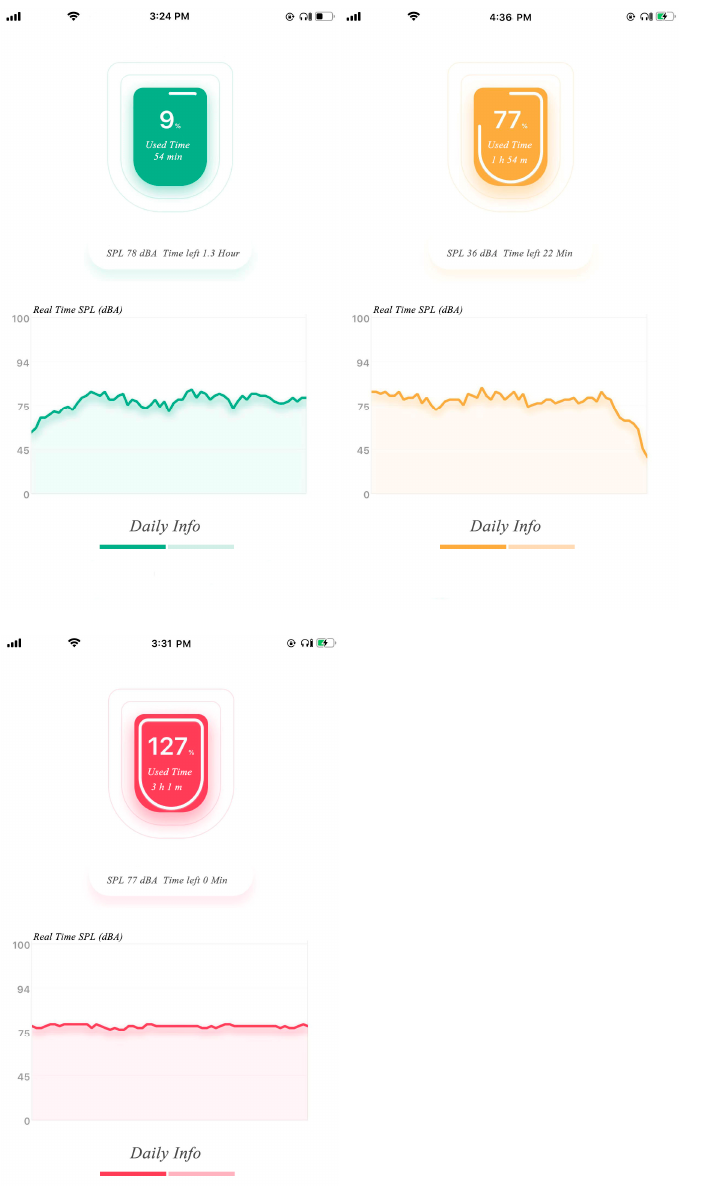
Figure 7. Daily dose usage status.